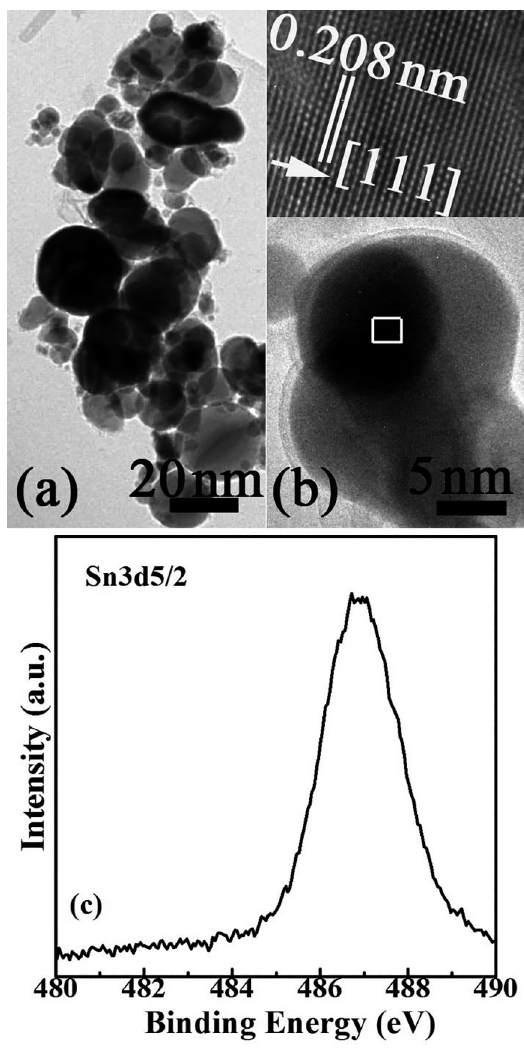
Figure 2: (a) TEM of SnO-coated FeNi nanocapsules and (b) HRTEM image of FeNi nanocapsules, the inset is the HRTEM image of the dotted area in (b) and (c) XPS spectrum and the corresponding fitting curves of the Sn 3d5/2 electrons on a etching depth of 1 nm.